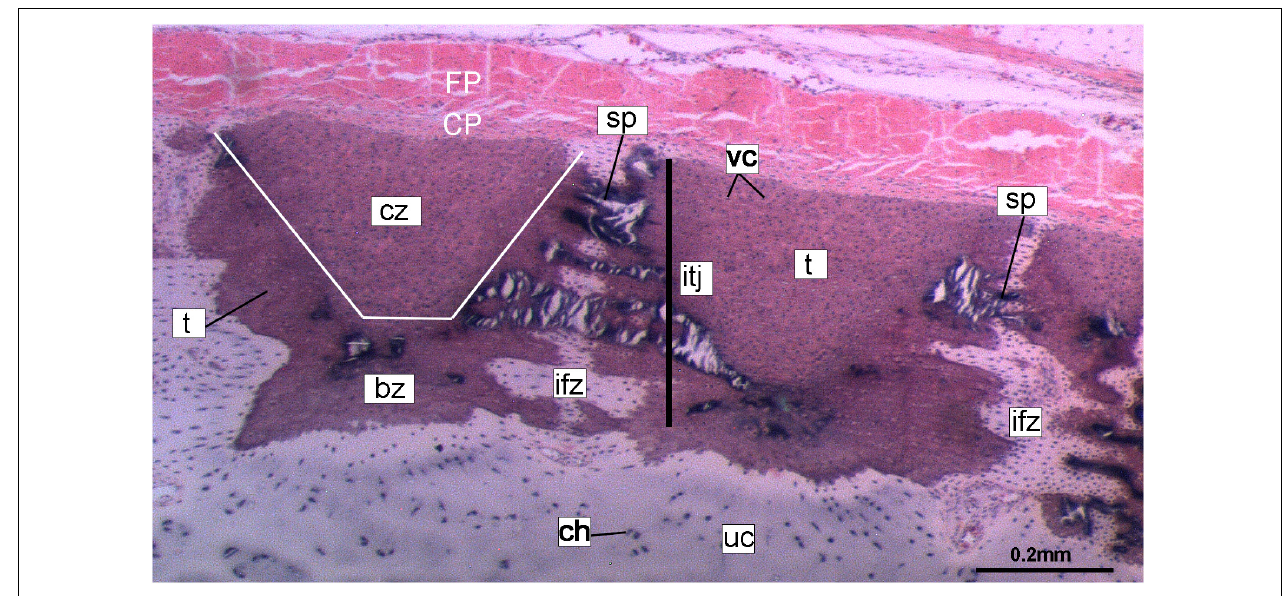
FIGURE 10 | Histological section of tessellated cartilage of a batoid ray ( Raja ). Abbreviations: as in previous Figures also bz, body zone; CP, chondrogenic perichondrium cz, cap zone; ifz, intertesseral fibrous zone; itj, intertesseral joint; FP, fibrous perichondrium; sp., spoke; t, tesserae; vc, vital